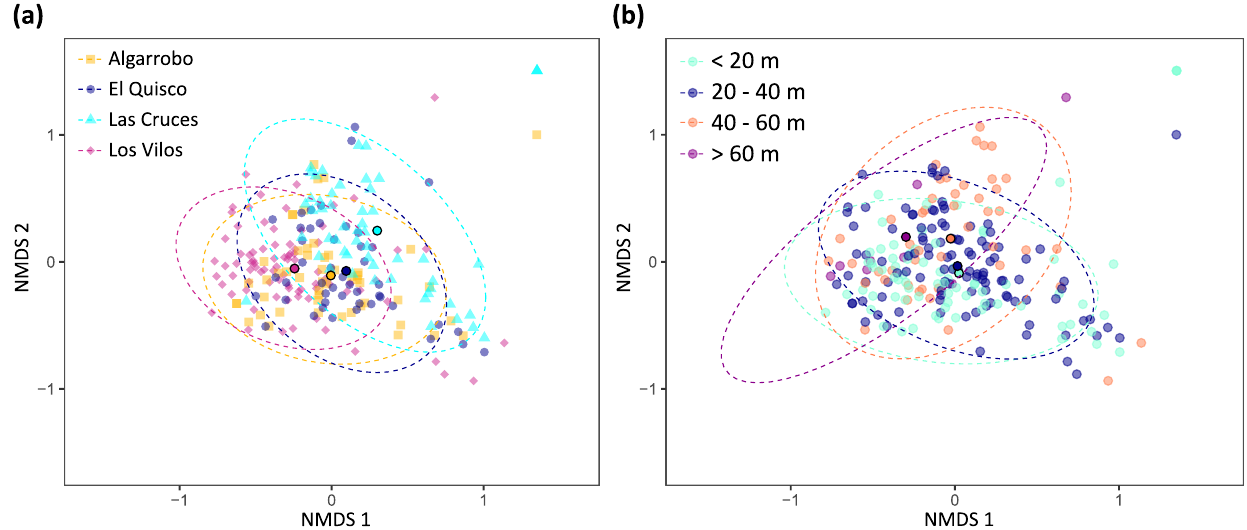
Figure 7. Non-metric multidimensional scaling (nMDS) plot using a Bray–Curtis dissimilarity matrix (dimensions = 3, stress = 0.13, Shepard plot non-metric R 2 = 0.98). ( a ) Sites. ( b ) Depth strata. Ellipses include 95% of the data for each group. Dots with black borders and a more intense colour indicate the centroids for each